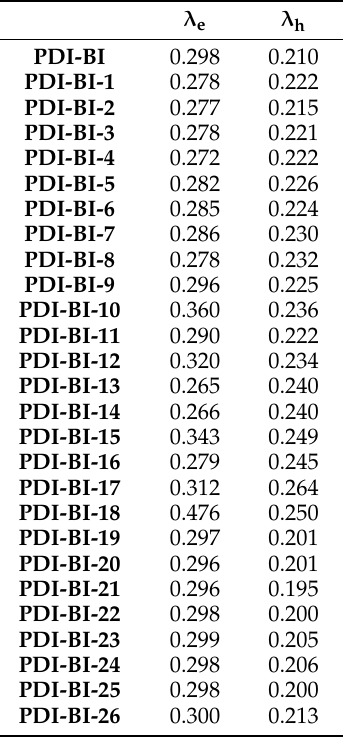
Table 3. Calculated λ e and λ h (eV) values of PDI-BI and its